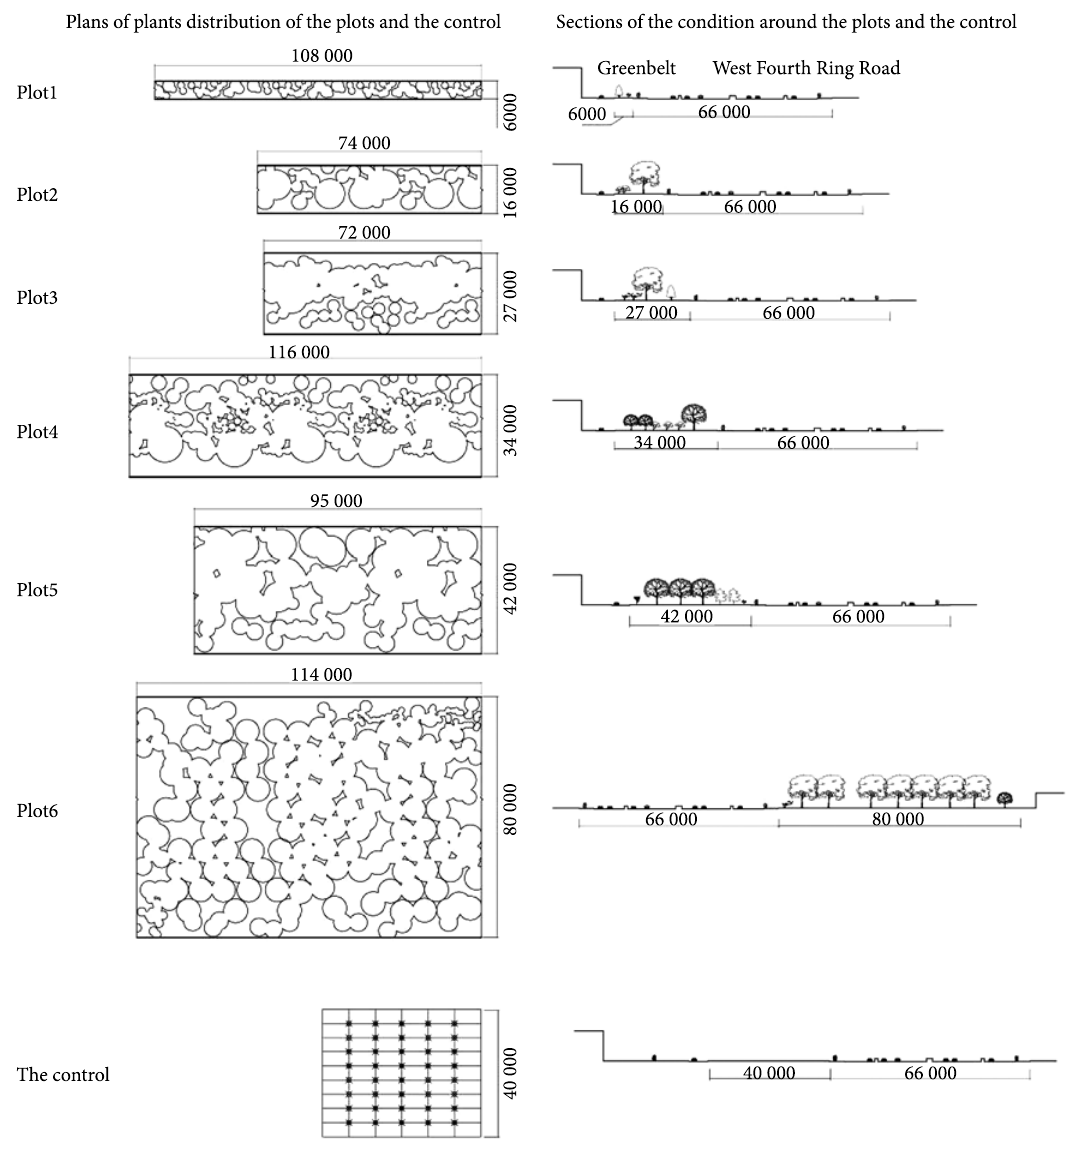
Fig. 2. Diagrams of plants distribution within the green belts and sections of the areas around the green belts Table 1. Meteorological conditions and traffic flow counts during the testing periods at the study site Expe rimental